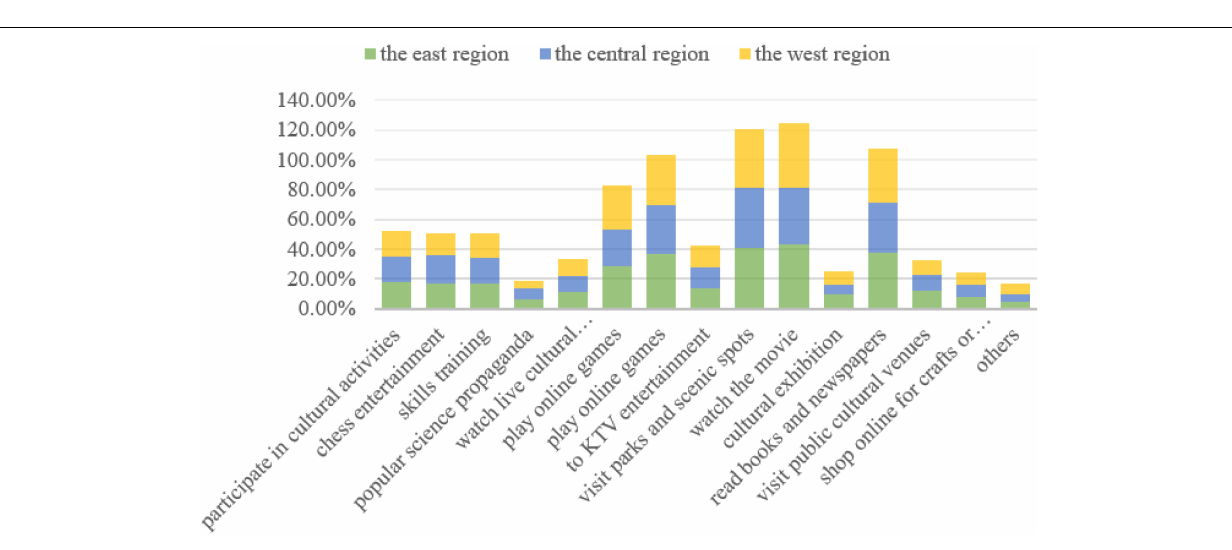
FIGURE 2 | The participation rate of public cultural activities in east, central and west regions in